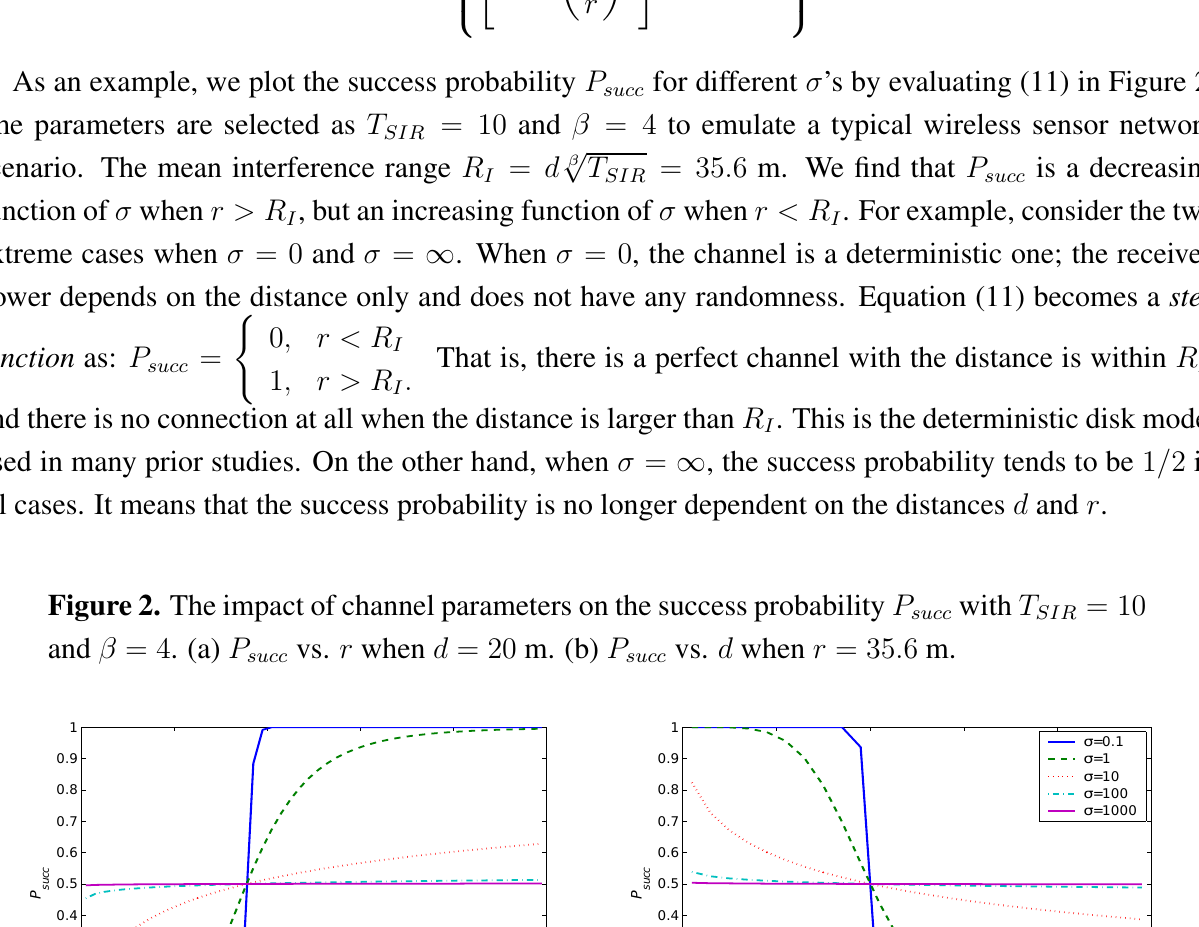
vs. d when r = 35 . 6 succ